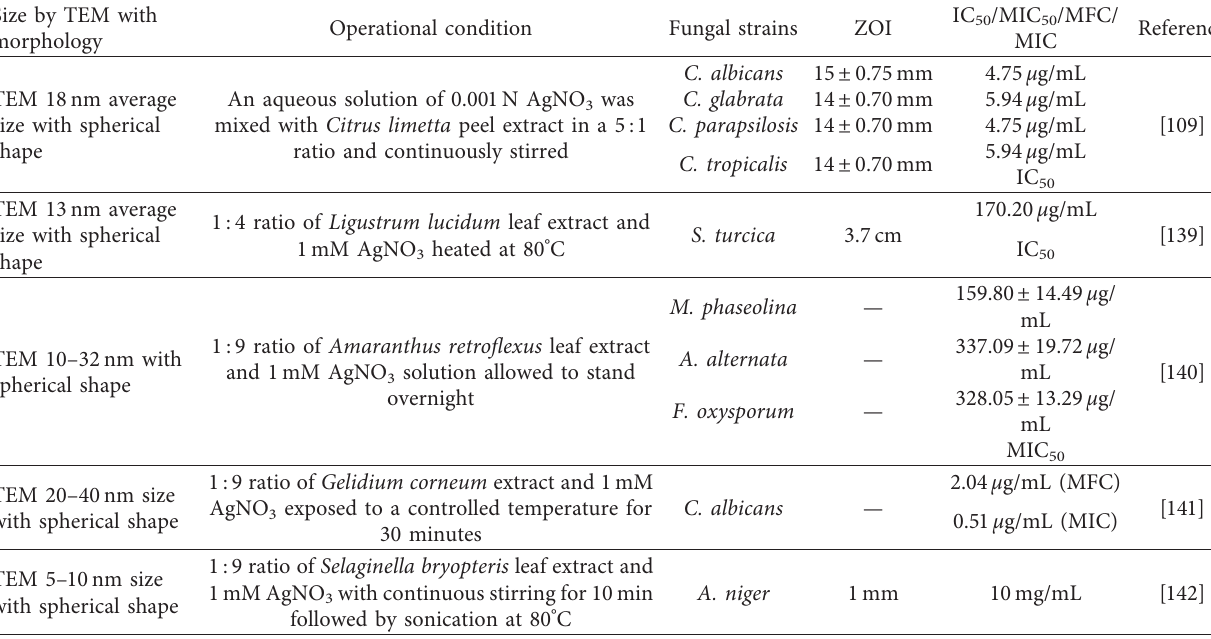
Table 3: Morphology of plant-mediated synthesized Ag NPs and their antifungal activity.